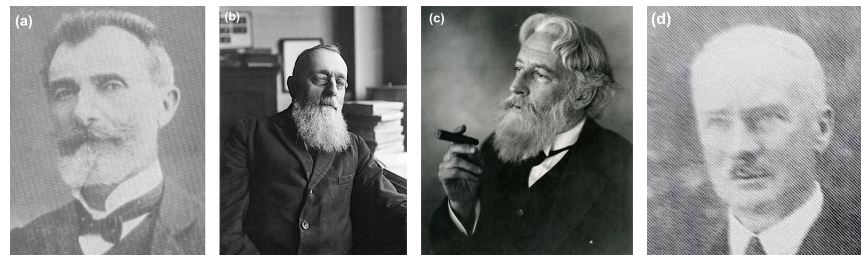
Figure 1. Key personnel responsible for the formation of IAVCEI. (a) Annibale Riccò, first president of IAVCEI (source: Osservatorio Astronomico di Palermo website – http://www.astropa.inaf.it/annibale-ricco/, last access: 11 July 2018). (b) Alfred Lacroix, the first co-vice president and second president (source: Wikipedia – https://en.wikipedia.org/wiki/Alfred_Lacroix, last access: 11 July 2018). (c) Henry S. Washington, first co-vice president (source: Milton, 1991, American Academy of Science). (d) Alessandro Malladra, first secretary-general, subsequent president and first editor of Bulletin volcanologique (source: http://www.minerbook.it/, last access: 11 July 2018). Parts (a) , (b) and (d) are public domain; part (c) permission was granted by US National Academy of